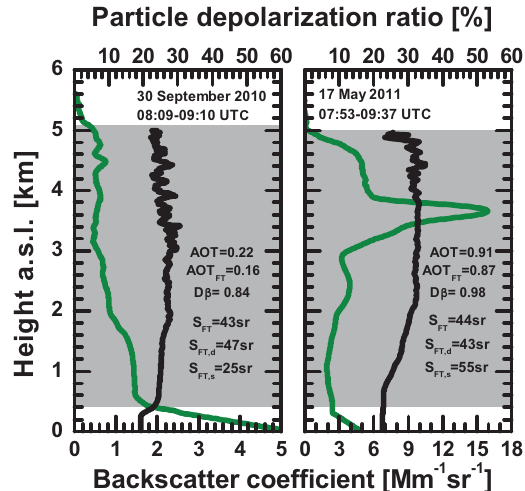
Figure 3. 532nm particle backscatter coefficient (green) and par- ticle linear depolarization ratio (black) during a Saharan dust out- break on 30 September 2010 (left) and a Middle East desert dust outbreak on 17 May 2011 (right). The gray-shaded areas indi- cate the identified main FT dust layers. Total tropospheric AOT, AOT FT for the free troposphere, and several retrieved lidar ra- tios ( S FT , S FT,d ) are given as numbers. The dust fraction was DF = 0.72 (30 September) and 0.96 (17 May). Assumed lidar ra- tios are S PBL = 30sr and S FT,s = 25sr (left panel) and 55sr (right panel). The relative uncertainty in the backscatter coefficient and depolarization ratio is about 10% (Mamouri et al.,